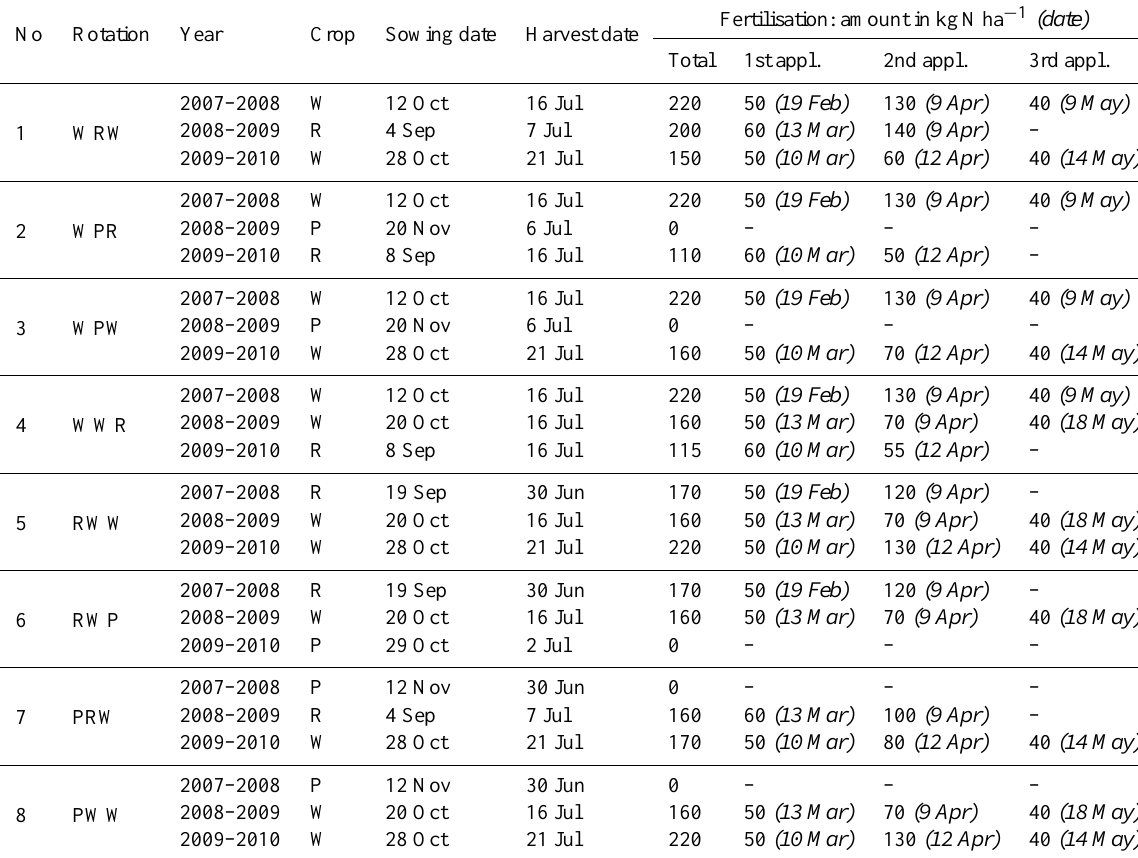
Table 2. Sowing and harvest dates of each crop, total rate, dates and rates of nitrogen fertilizer applied on each crop according to each rotation.